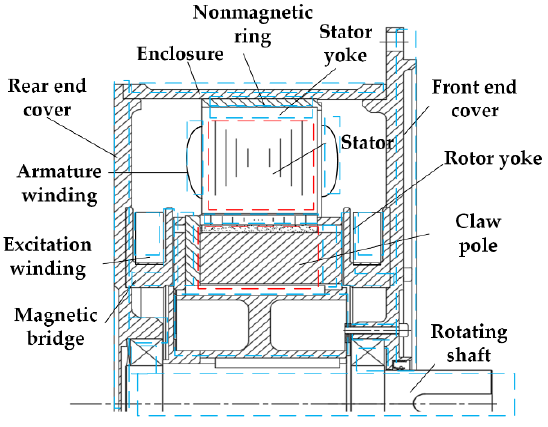
Figure 2. Different solving region of DHEG.